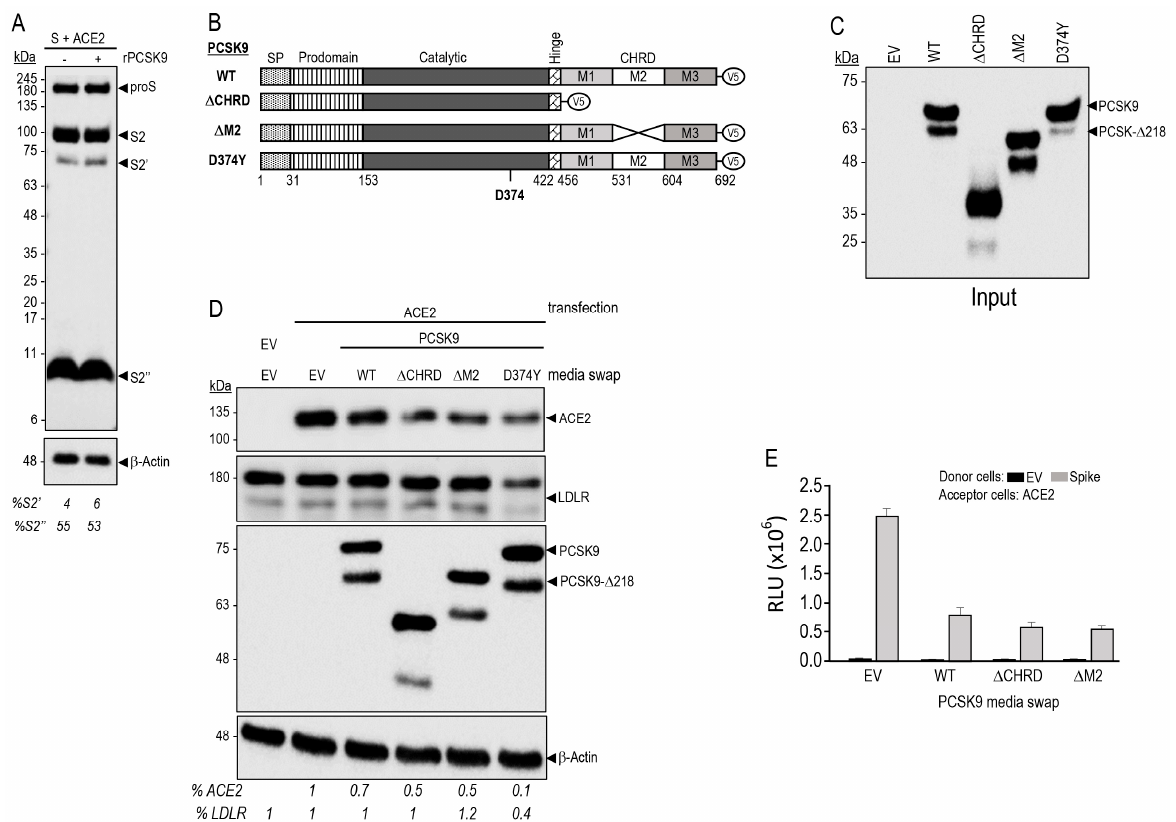
Figure 7. PCSK9 enhances the degradation of ACE2 and reduces cell-to-cell fusion. ( A ) Hela cells transiently transfected with cDNAs encoding WT spike glycoprotein and ACE2 were incubated for 18 h with 5 μ g/mL of recombinant PCSK9 [66]. Forty-eight hours post-transfection, proteins in cell lysates were resolved by SDS-PAGE and analyzed by Western blot using mAb-V5. The migration positions of reference molecular weight proteins are indicated. Note that we had to overexpose the gel to better see S2 (cid:48) . ( B ) Schematic representation of V5-tagged WT human PCSK9, PCSK9 domain deletion mutants ( ∆ CHRD and ∆ M2, lacking the CHRD and M2 domains, respectively) and the gain- of-function mutant D374Y. SP: Signal Peptide. ( C ) Conditioned media were produced by transfection of HEK293 cells with cDNAs coding for PCSK9 WT or its mutants. The media were collected 48 h post-transfection, centrifuged 20 min (300 × g at 4 ◦ C), the production of the conditioned media was then analyzed by Western blot (input). ( D ) HeLa cells were pre-incubated in serum-free-medium for 1 h, followed by the indicated conditioned media swap for 18 h. The cells were then collected and analyzed by Western blot. The levels of ACE2 and LDLR are shown as a percentage of total protein relative to β -actin. ( E ) Donor HeLa cells were transiently transfected with vector expressing empty vector (EV) or spike-glycoprotein WT (S). The acceptor TZM-bl cells were transfected with vector coding for ACE2 receptor. Forty-eight hours post-transfection cells were detached and re-suspended in indicated media (swap) and put in co-culture for 18 h. The extent of fusion is represented as relative luminescence units